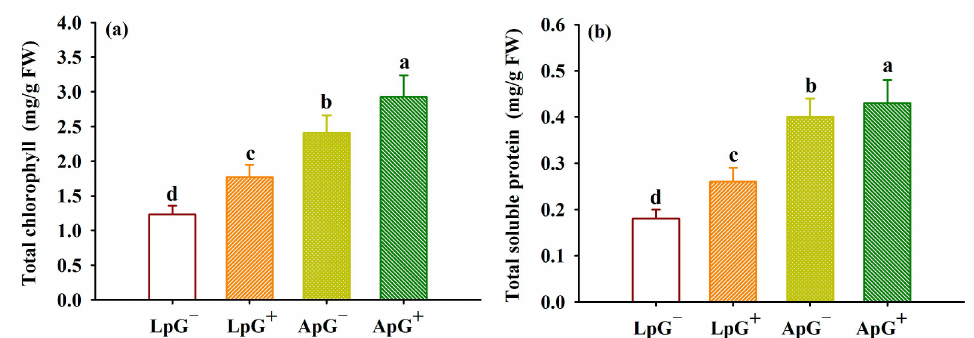
Figure 4. Changes in leaf total chlorophyll ( a ) and total soluble protein ( b ) concentrations of Poly- gonum cuspidatum inoculated with Glomus mosseae in low and approximate P levels. Different letters on the bars indicate significant ( p < 0.05) differences between treatments. See Figure 1 for